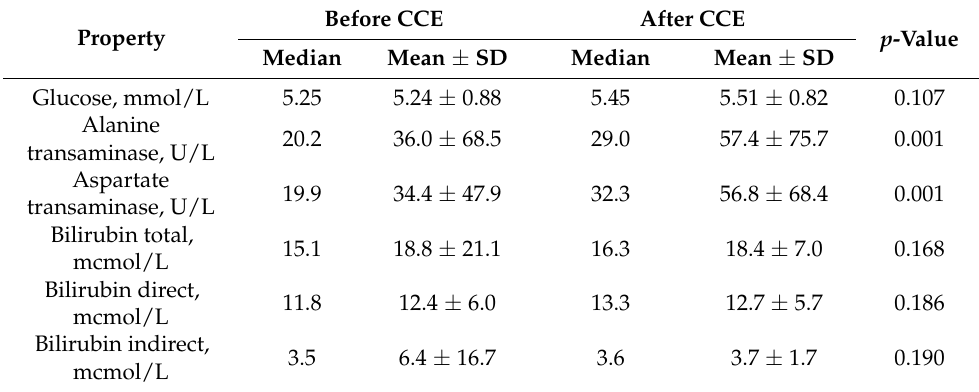
Table 8. Blood biochemical test results before and after